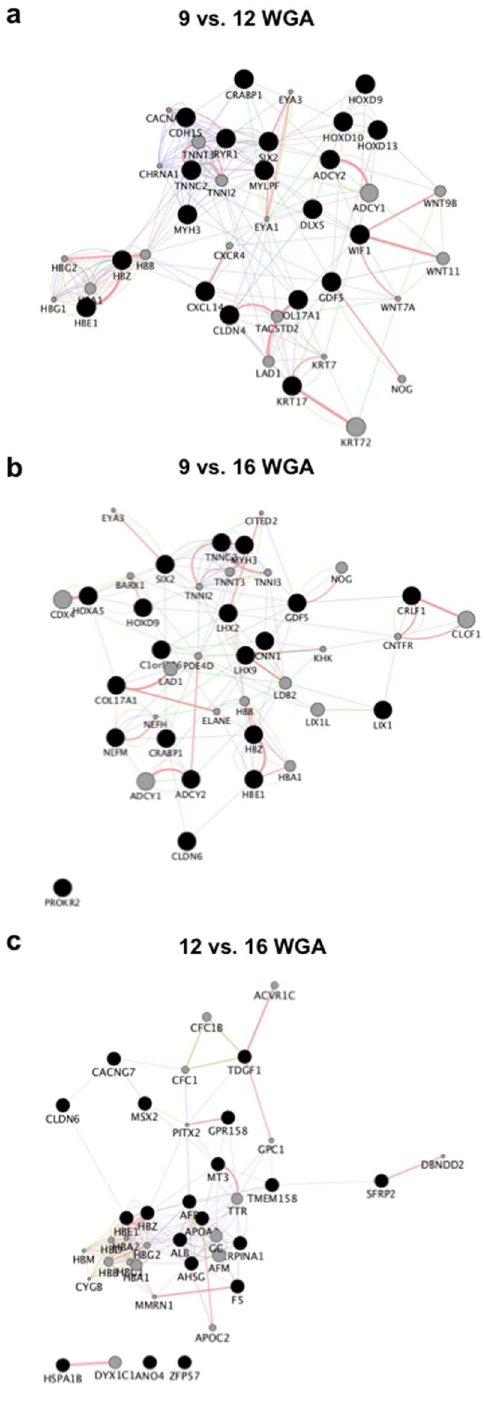
Figure 3. Predictive gene network analysis for significantly downregulated genes. We performed that same predictive gene network analysis as in Fig. 2, except the 20 genes with the greatest log2 fold decrease between age comparisons (black circles) were used. ( a – c ) Network analysis for 9 compared to 12 weeks gestation age (WGA), 9 compared to 16 WGA, and 12 compared to 16 WGA. The most significant gene ontology functions were analysed from the resultant network (see Main Text). Edges are colour coded to signify the predicted connections between nodes; co-expression: purple; co-localisation: blue; genetic interactions: green; shared protein domains: yellow; predicted: orange; physical interactions: pink; pathway: light